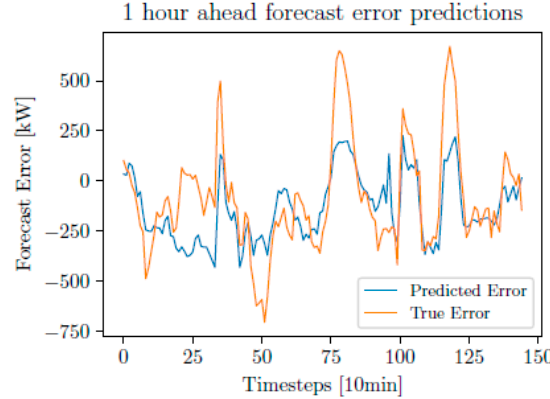
Figure 18. One-hour-ahead error forecasts.